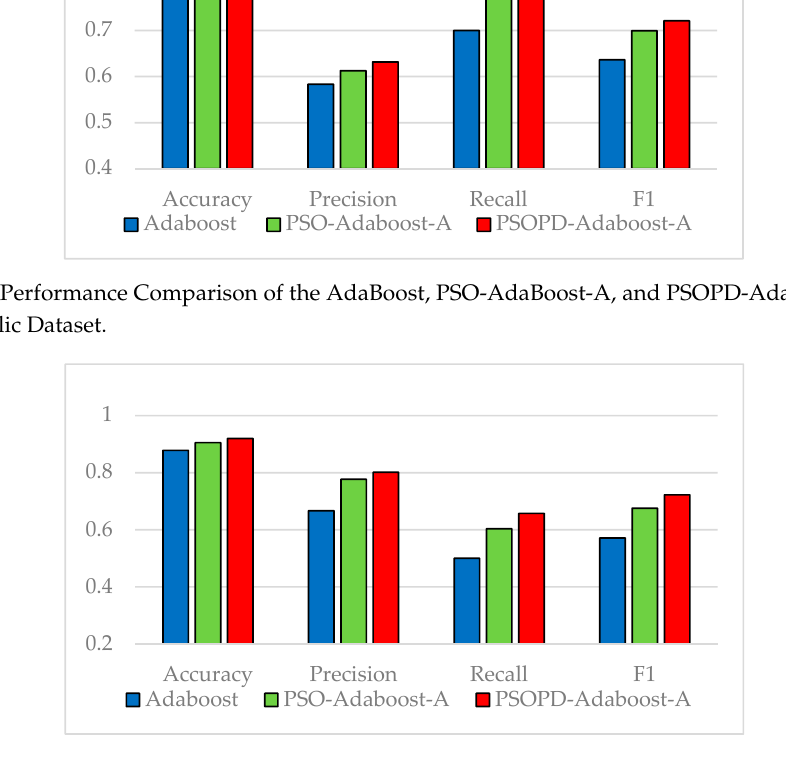
Figure 11. Performance Comparison of the AdaBoost, PSO-AdaBoost-A, and PSOPD-AdaBoost-A on JM1 Dataset.